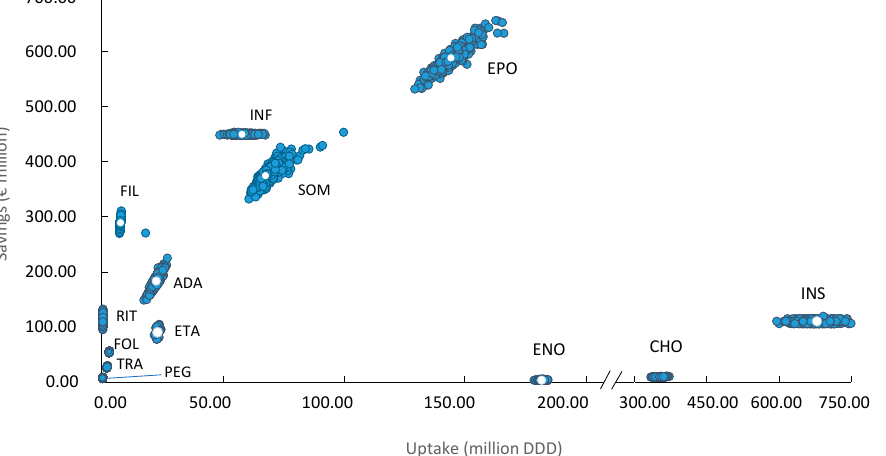
Figure 4. Scatter plot of 1000 Monte Carlo simulations. Vertical axis represents aggregated saving ( € million) for each molecule in the period 2009–2019. Horizontal axis represents the total amount of DDD (million) consumed in this period for each molecule. White dots represent the base case values. SOM: somatropin; FIL: filgrastim; EPO: epoetin; FOL: follitropin alfa; INF: infliximab;